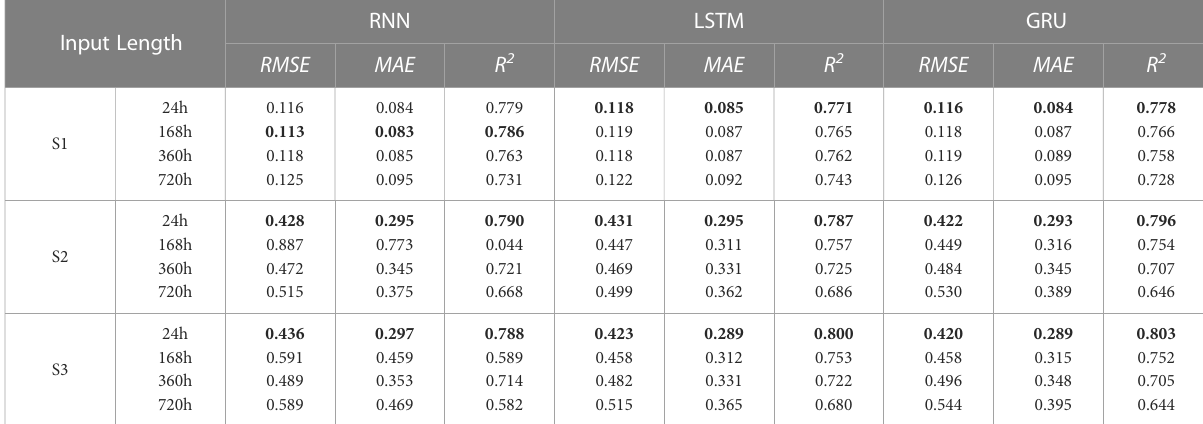
TABLE 2 The prediction result of signi fi cant wave height.